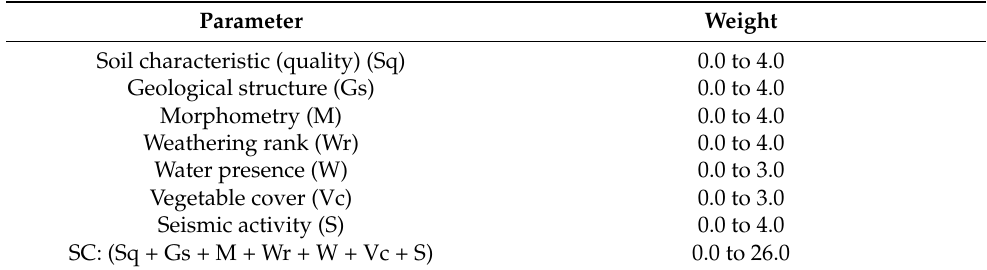
Table 5. Main parameters and weights assigned to soil in the susceptibility coefficient estimation, based on [21,57,61,63,64].